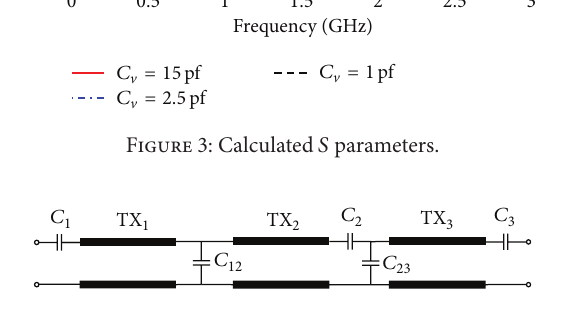
Figure 4: Transmission line equivalent